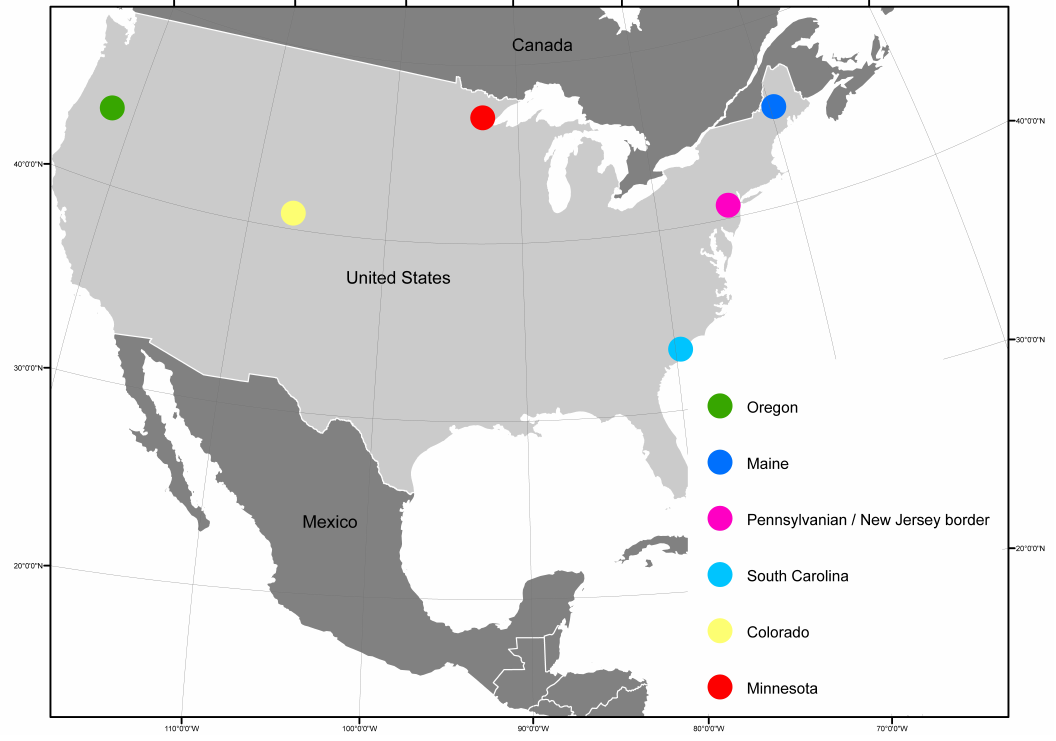
Figure 2. Study sites across the